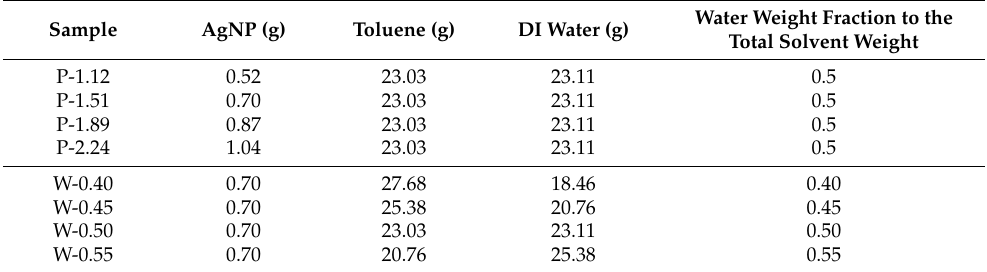
Table 1. Emulsion formulations with various AgNP concentrations and water weight fractions. (P stands for the AgNP concentration with respect to total solvent weight; W stands for the water weight fraction based on the total solvent weight). Other additives for preparing emulsions, such as Span 60, cyclohexanone, and APS, are not listed in the table.